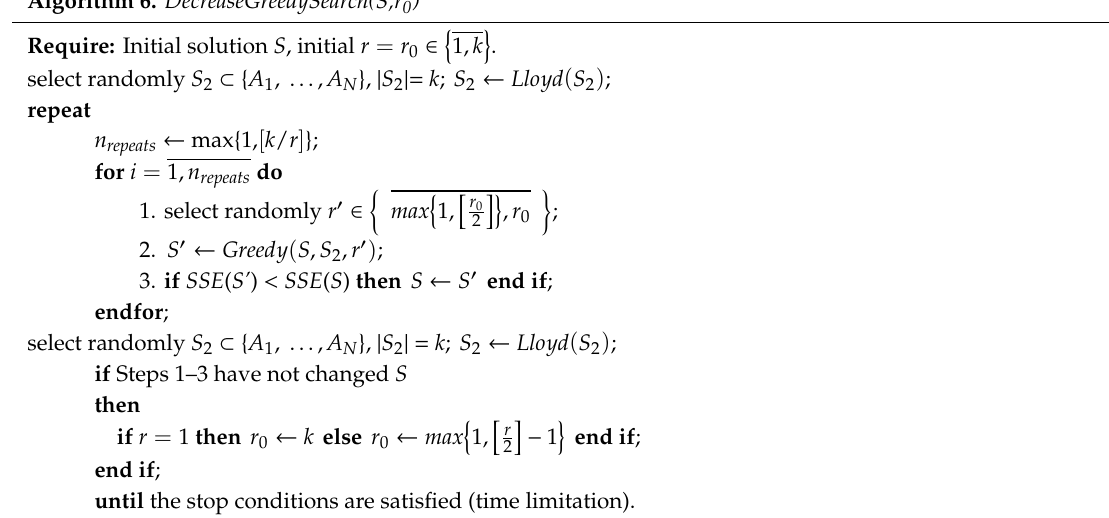
Algorithm 6. DecreaseGreedySearch ( S,r 0 )